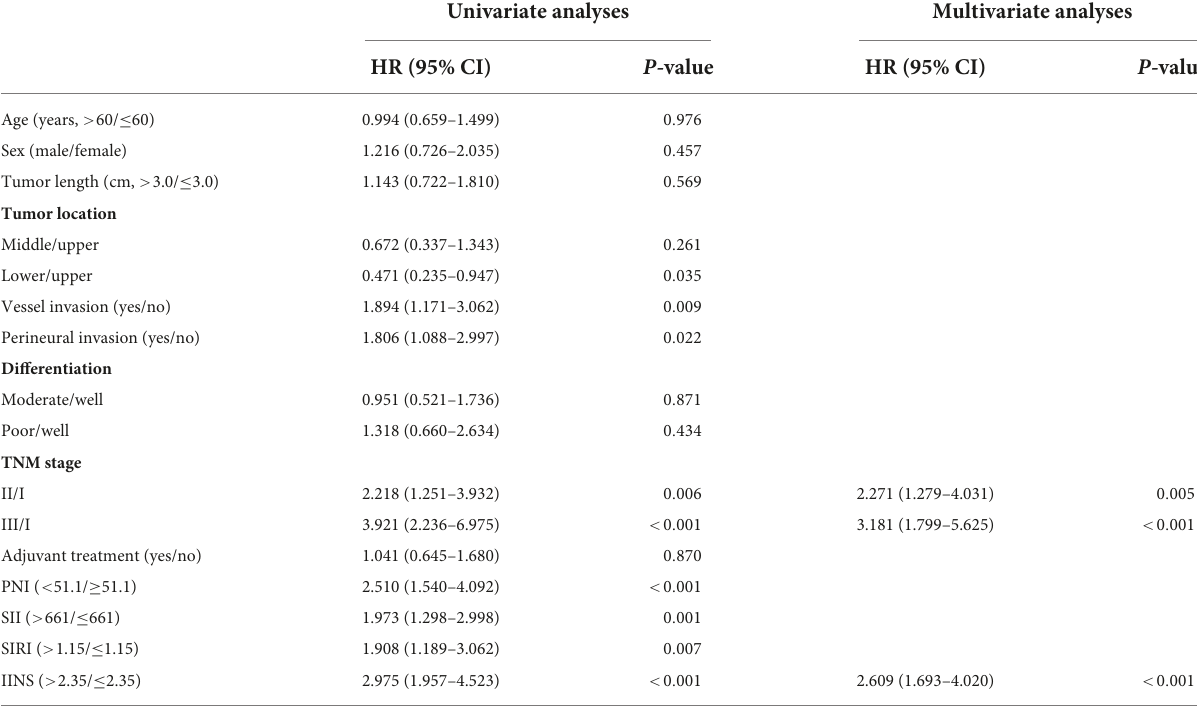
TABLE 4 Univariate and multivariate Cox analyses of cancer-specific survival (CSS) in validation set. Univariate analyses Multivariate